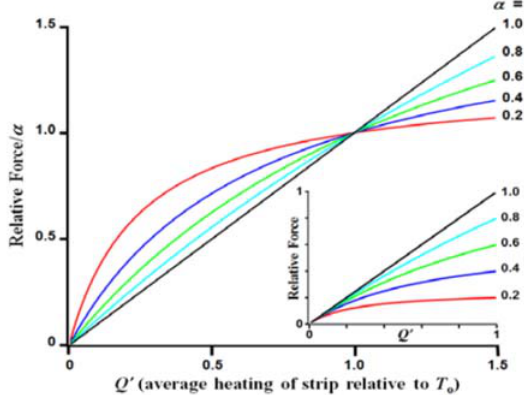
Figure 4. Relative force as a function of applied heat (Equation (6)) for several values of α , the fractional length that is heated. For the actuator strip being modeled from [12], the values of the independent variable Q’ from 0 to 1.5 correspond to total heat deposition of Q from 0 to 5.77 J. The curves become increasingly nonlinear for decreasing values of α . The inset plots the relative force for each value of α on the same scale, and shows that the force decreases as the same amount of heat is confined to a smaller length of the